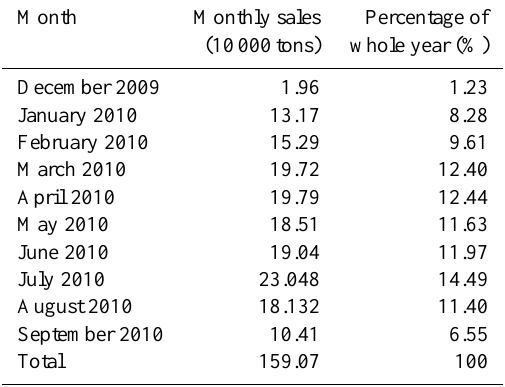
Table 3. Amount of sugar sold monthly during the 2009/2010 sea-